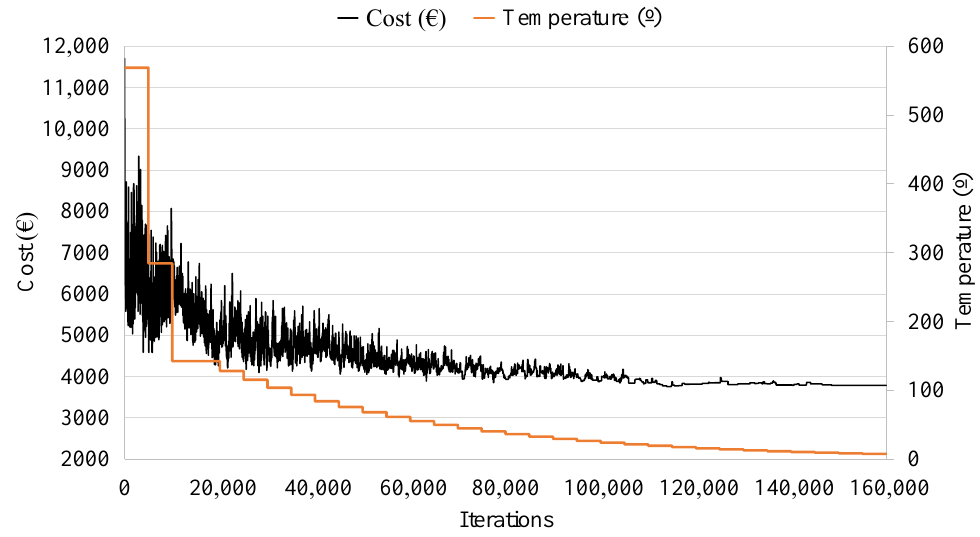
Figure 4. Simulated annealing trajectory for the cost and temperature as a function of